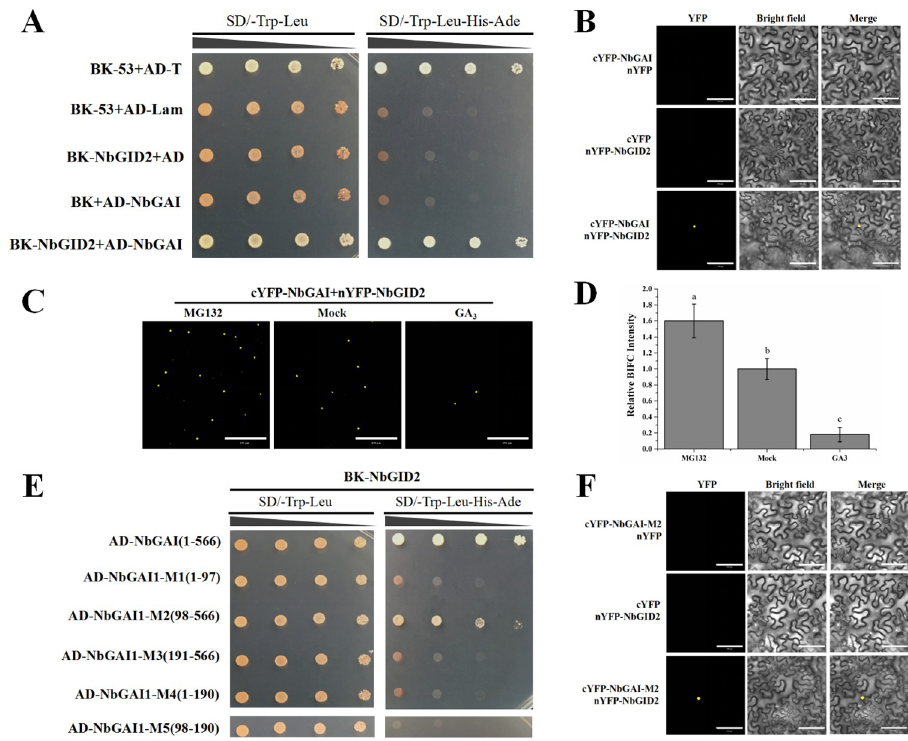
Fig 4. The interaction between NbGAI and NbGID2 enhances the ubiquitin-26S proteasome-dependent degradation of NbGAI. (A) Results of the Y2H assay show the interaction between NbGAI and NbGID2. (B) Results of the BiFC assay show the interaction between NbGAI and NbGID2 in N . benthamiana leaf cells. Leaves co- expressing cYFP-NbGAI and nYFP, nYFP-NbGID2 and cYFP or cYFP-NbGAI and nYFP-NbGID2 were examined and imaged under a confocal microscope at 48 hpi. Scale bar = 100 μ m. (C) Degradation of NbGAI is ubiquitin-26S proteasome dependent. Fusion cYFP-NbGAI and nYFP-NbGID2 were transiently co-expressed in N . benthamiana leaves. The infiltrated leaves were sprayed with a solution containing 50 μ M MG132 at 12 h before confocal microscopy or with a solution containing 50 μ M GA 3 or 0.8% ethanol (control) at 2 h before confocal microscopy. (D) Fluorescence intensities from the BiFC assays were quantified based on the numbers of nuclei with GFP fluorescence. Different letters above the bars indicate significant differences among the treatments at the P < 0.05 level. These experiments were performed with three independent biological replicates with similar results. (E) Results of the Y2H assay show the positive interaction between NbGAI-M2 and NbGID2. (F) Results of the BiFC assay show the positive interaction between NbGAI-M2 and NbGID2 in planta . Scale bar = 100 μ m. The procedures of the Y2H and BiFC assays are similar to those described in Fig